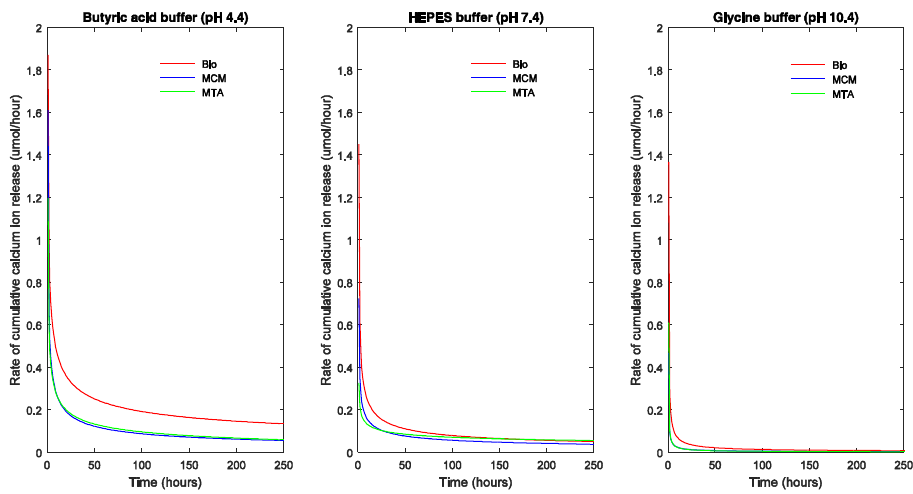
Figure 4. Cumulative calcium ion release rate of the TSCs as a function of the pH of the solution.